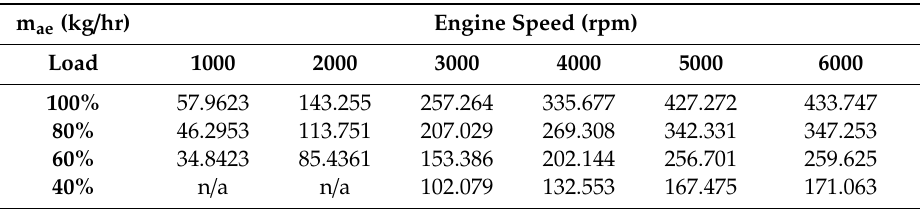
Table 6. Air mass flow rate at each engine speed and load.